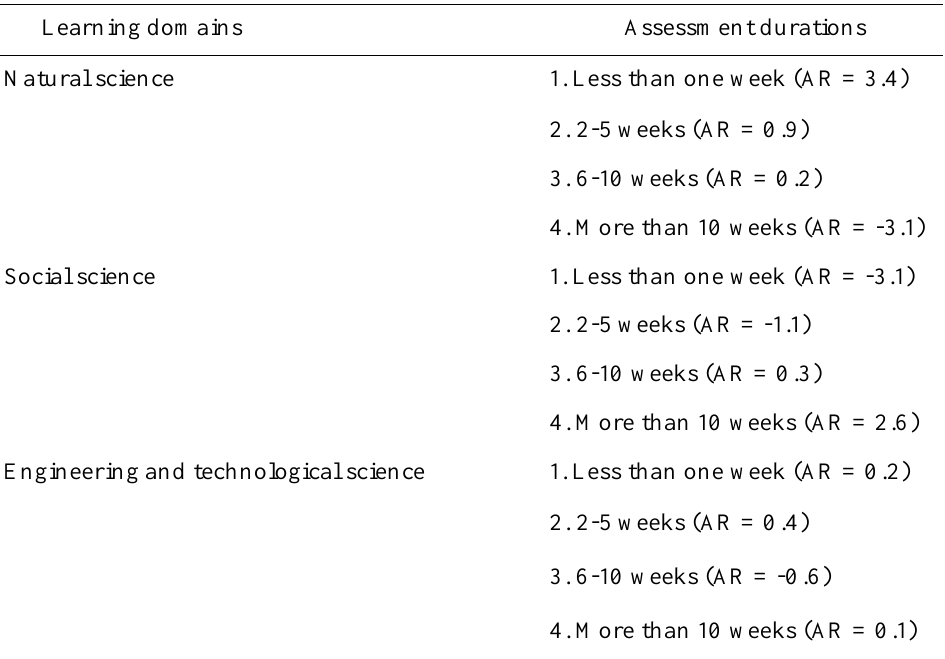
The Relationships Between Learning Domains and Assessment Durations Learning